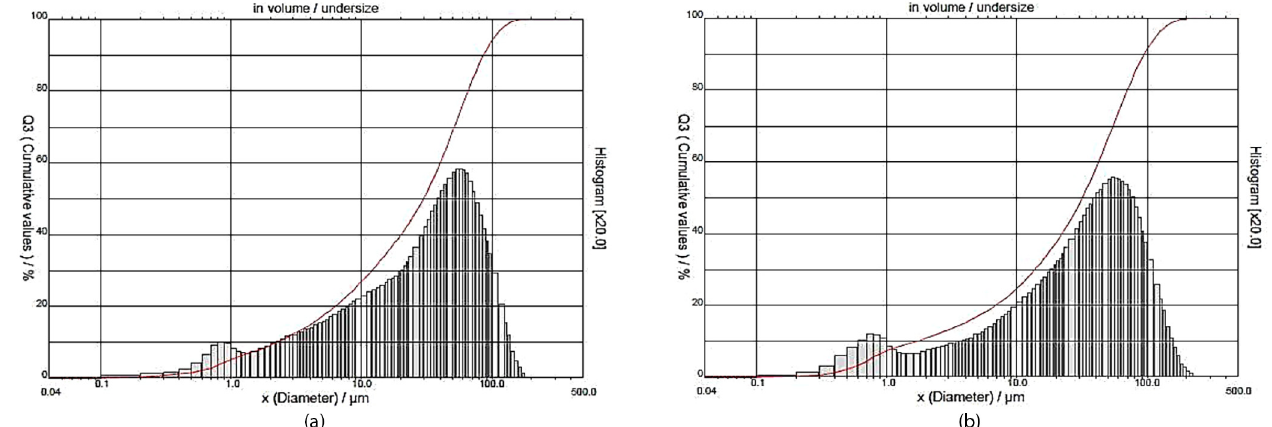
Fig. 3. Particle size distribution in SiC and h-BN powder samples.